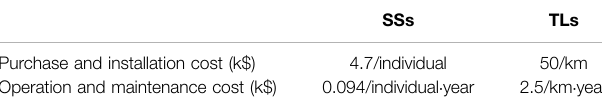
TABLE 6 | Economic data for SSs and TLs.